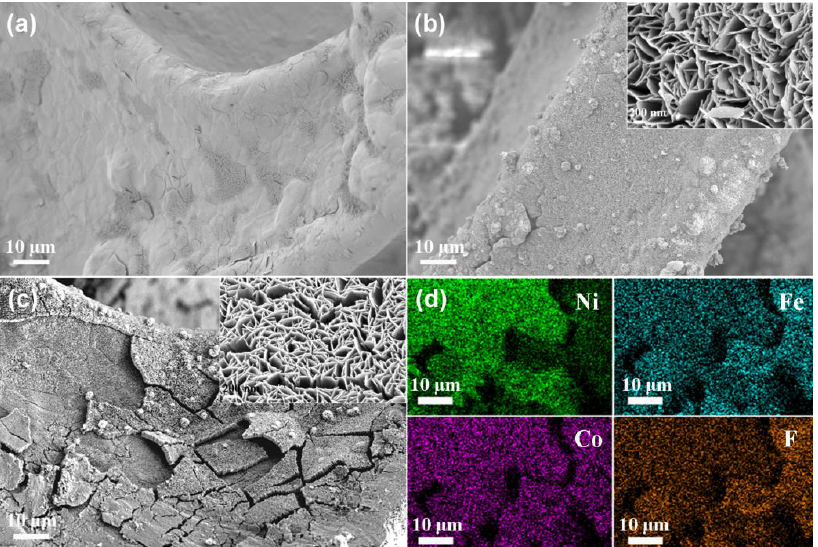
Figure 1. FESEM images of Ni foam ( a ), Ni-CoFe 2 O 4 foam ( b ) and superhydrophobic Ni-CoFe 2 O 4 foam ( c ). Element distribution of the superhydrophobic Ni-CoFe 2 O 4 foam ( d ). To analyze the surface structure and composition of the composite, the results of XRD, TEM and XPS were analyzed. Notably, the CoFe 2 O 4 powder used in the XRD and TEM analysis was obtained through ultrasonic dissection. As shown in Figure 2a, the characteristic peaks (111), (200) and (220) of Ni found in the diffraction peaks of both CoFe 2 O 4 and superhydrophobic CoFe 2 O 4 indicated that Ni particles were also stripped. The characteristic peaks (200) and (220) of CoFe 2 O 4 appeared, proving that CoFe 2 O 4 was formed on the surface of the Ni foam, and the crystal structure of CoFe 2 O 4 was not changed through silane grafting. The nanosheet morphology of CoFe 2 O 4 was confirmed in the TEM image, and the lattice planes (101), (311) and (222) were analyzed based on the HRTEM image (Figure 2b). The lattice plane (111) of Ni and the lattice plane (222) as well as (440) of CoFe 2 O 4 were analyzed based on the SAED map (Figure 2c). As shown in Figure 2d, the surface of superhydrophobic CoFe 2 O 4 is composed of elements Co, Fe, O, Si, C and F, and the content of F is up to 48.1%, which effectively reduces the surface energy. Further fine spectral analyses of Co and Fe revealed that CoFe 2 O 4 had a mixed valent state consisting of Co 2+ , Co 3+ , Fe 2+ and Fe 3+ (Figure 3a,b). Relevant information of the deconvolution is presented in Table S1. The superhydrophobic Ni-CoFe 2 O 4 foam exhibited its superhydrophobicity under the synergy of the micron-nanoscale roughness and low surface energy. As shown in Figure 3c, the water droplets spread rapidly on the surface of the Ni-CoFe 2 O 4 foam, showing their superhydrophilicity. The inset shows that the surface exhibited a contact angle of 0 ◦ on the water. After silane treatment, the surface of the superhydrophobic Ni-CoFe 2 O 4 foam showed a non-wetting state with a contact angle of 157 ◦ . To verify the organic solvent removal property of the superhydrophobic Ni-CoFe 2 O 4 foam, cyclohexane was used as the target organic solvent. When the superhydrophobic Ni-CoFe 2 O 4 foam contacted the interface between cyclohexane and the water, cyclohexane was adsorbed, leaving a blank water